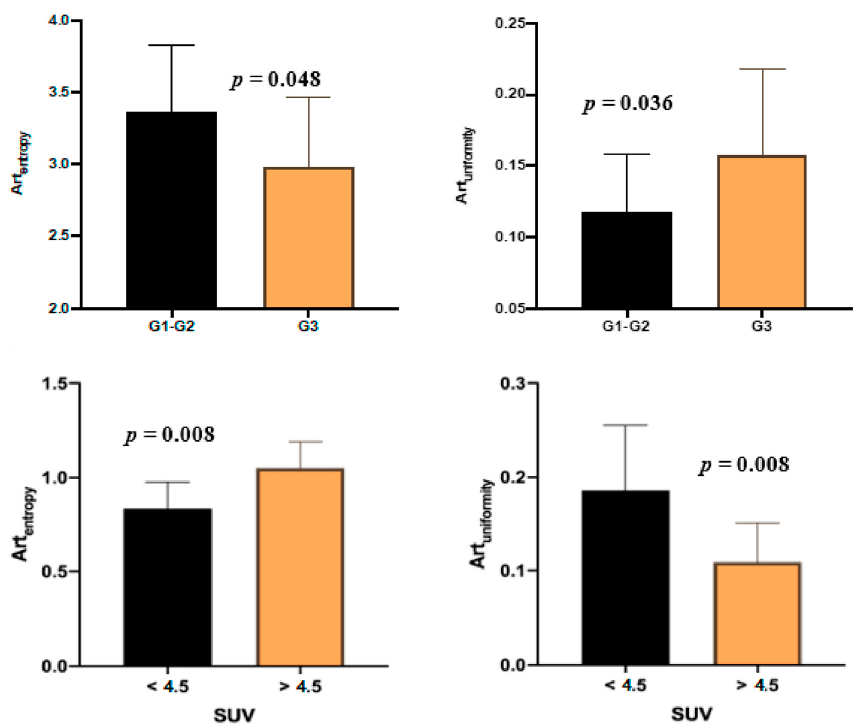
Figure 2. Comparison bar graph of the mean values of Art entropy and Art uniformity in the di ff erent groups for tumor grade (G) and 18 F-FDG standardized uptake values